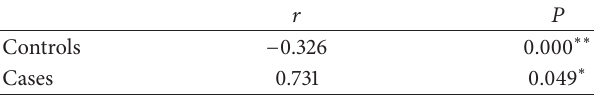
Table 2: Table showing correlation between serum and salivary creatinine in control and CKD patients using Pearson correlation.